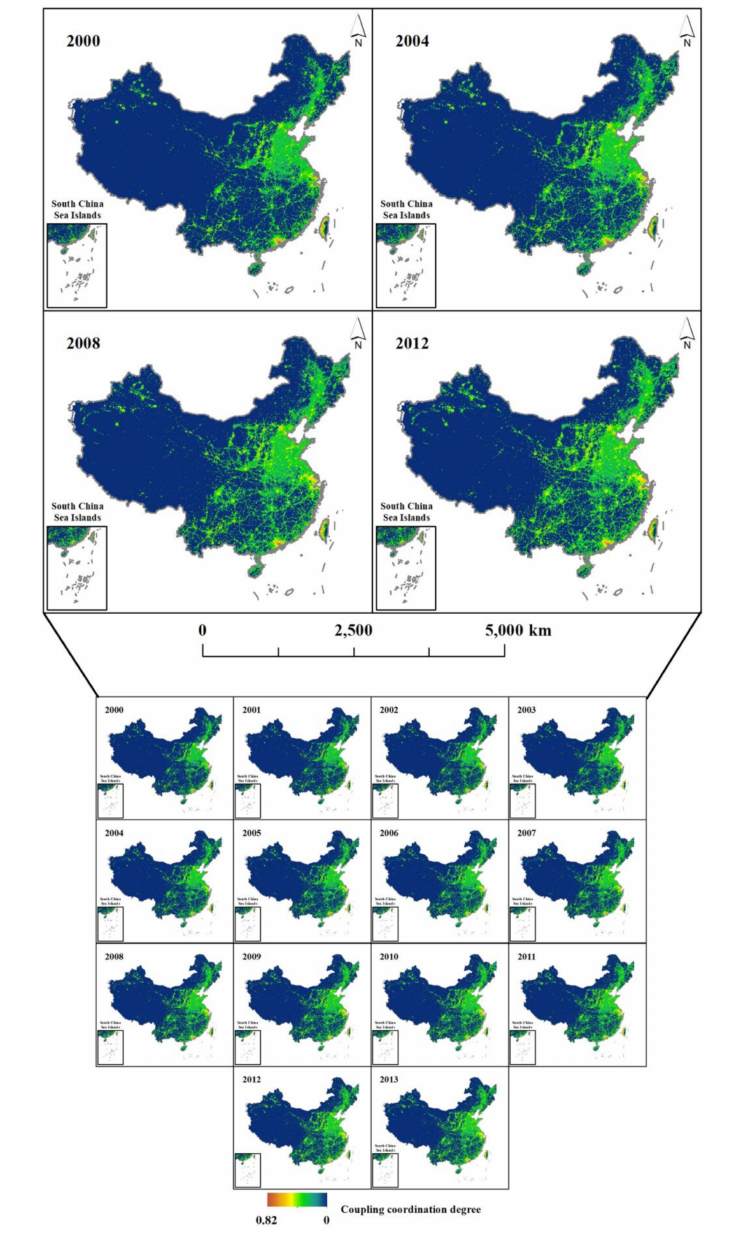
Figure 9. Spatial distribution map of CCD data in China from 2000 to